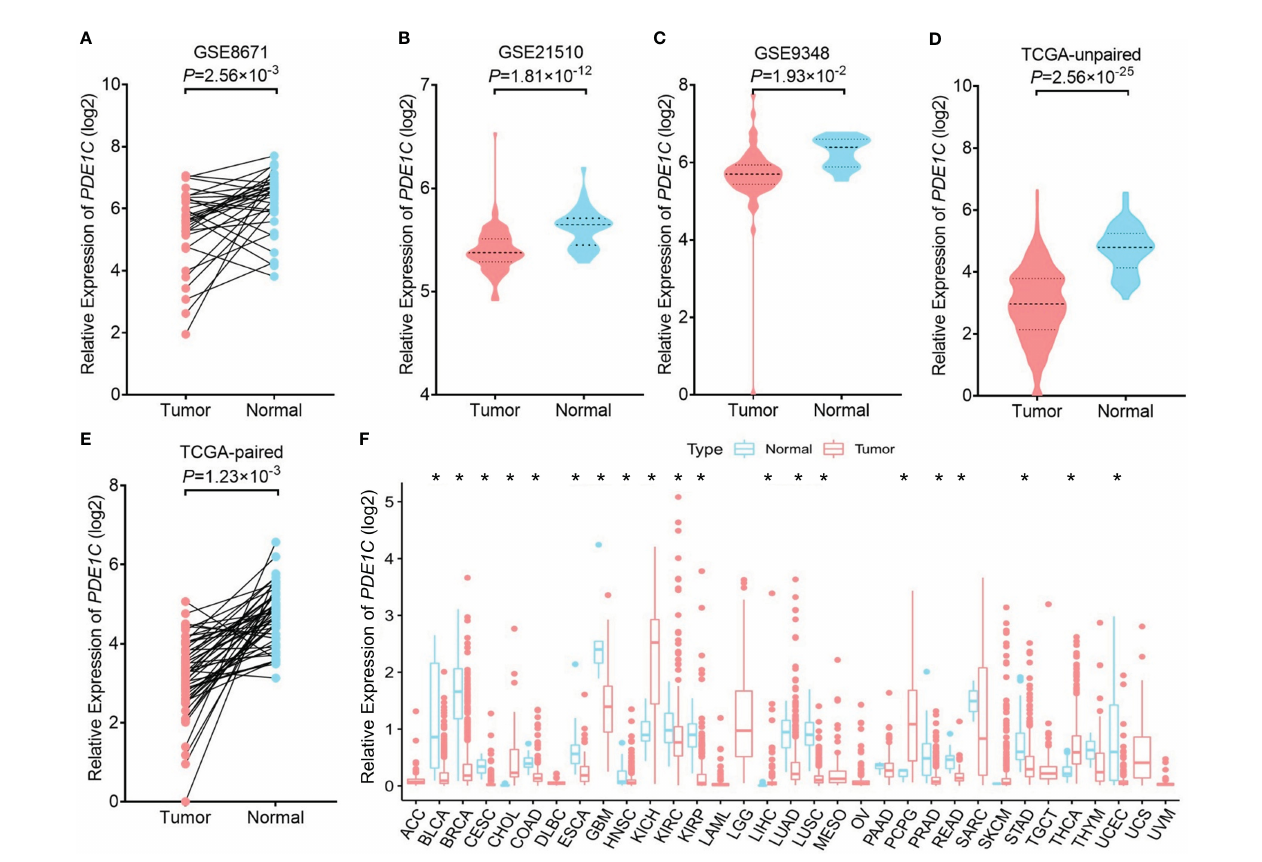
FIGURE 2 mRNA expression levels of PDE1C in cancer and para cancer tissue. The expression of PDE1C in the GSE8671 (A) , GSE21510 (B) , GSE9348 (C) , TCGA database (D, E) are shown. (F) Expression of PDE1C in pan-cancer. ACC, adrenocortical carcinoma; BLCA, bladder urothelial carcinoma; BRCA, breast invasive carcinoma; CESC, cervical and endocervical cancers; CHOL, cholangiocarcinoma; COAD, colorectal adenocarcinoma; DLBC, lymphoid neoplasm diffuse large B-cell lymphoma; ESCA, oesophageal carcinoma; GBM, glioblastoma multiforme; HNSC, head and neck squamous cell carcinoma; KICH, kidney chromophobe; KIRC, kidney renal clear cell carcinoma; KIRP, kidney renal papillary cell carcinoma; LAML, acute myeloid leukaemia; LGG, brain lower grade glioma; LIHC, liver hepatocellular; LUAD, lung adenocarcinoma; LUSC, lung squamous cell carcinoma; OV, ovarian serous cystadenocarcinoma; PAAD, pancreatic adenocarcinoma; PCPG, pheochromocytoma and paraganglioma; PRAD, prostate adenocarcinoma; READ, rectum adenocarcinoma; SARC, sarcoma; SKCM, skin cutaneous melanoma; STAD, stomach adenocarcinoma; TGCT, testicular germ cell tumour; THCA, thyroid carcinoma; TNYM, thymoma; UCEC, uterine corpus endometrial carcinoma; UCS, uterine carcinosarcoma. * P <